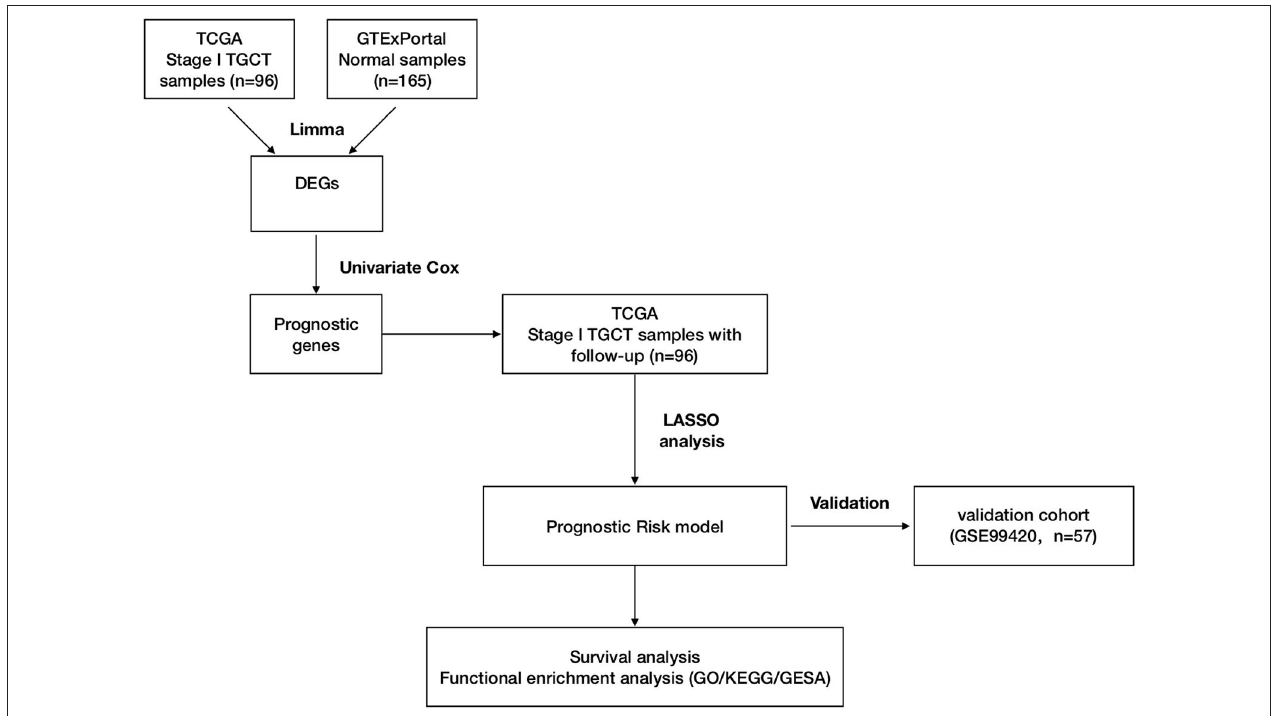
FIGURE 1 | Workflow of construction and validation of the risk score model. The figure shows the overall workflow of the prognostic model construction and validation.